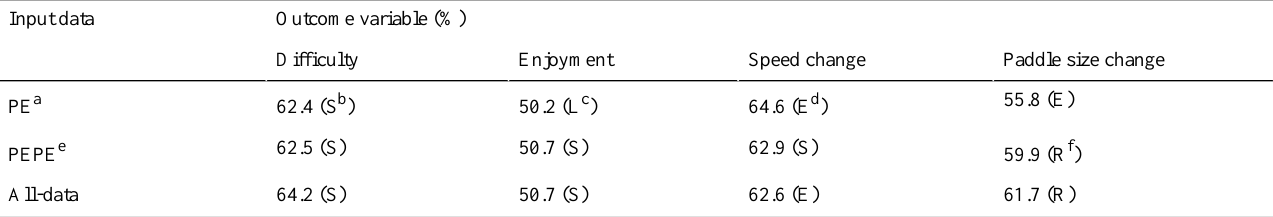
Table 3. Mean three-class classification accuracies for different combinations of input data modalities.